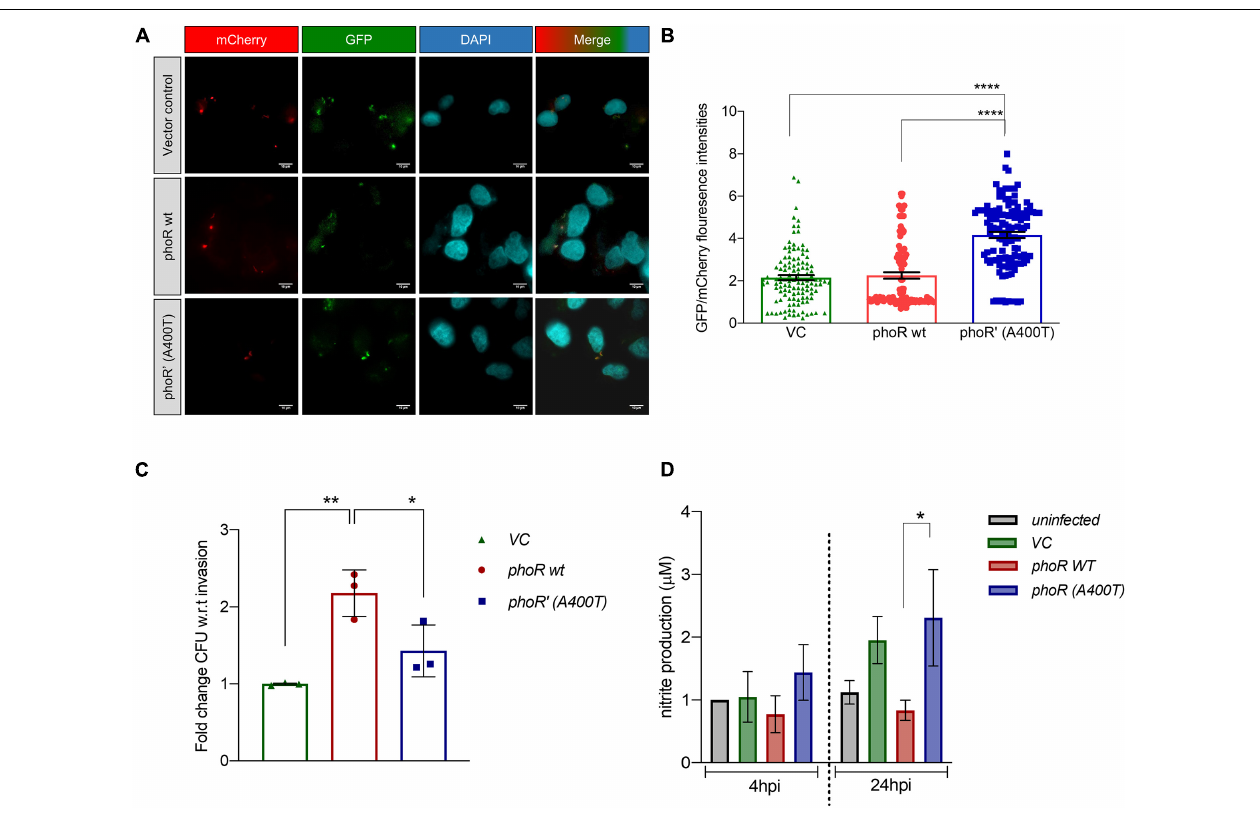
FIGURE 6 | Analysis of the effect of the phoR polymorphism by infection studies in host cells using H37Ra strain as a host strain. (A) Fluorescence microscopy images showing aprA induction upon infection in H460 lung epithelial cell line at 4 hpi. Top panel, a strain carrying vector alone; middle panel, PhoR wt; and lower panel, PhoR’ (A400T) mutant. mCherry marks constitutive promoter activity; green fluorescent protein (GFP), aprA marks promoter activity; DAPI marks the nucleus of the host cell; and merged image shows localization for all fluorophores. The brightness of merged image was increased to show presence of bacillary signal. (B) Quantification of relative fluorescence 4 hpi of intracellular bacilli by GFP/mCherry ratio for ∼ 100 bacilli. Cells were infected with H37Ra strains carrying aprA promoter-reporter plasmid along with an integrated copy of the empty vector, or vector containing either the wild-type or mutant phoPR operon. (C) Quantitation of the intracellular bacterial burden for various strains (as indicated) after infection in THP-1 differential macrophage cell line. Cells were infected with H37Ra strains an integrated copy of the empty vector, the wild-type or mutant phoPR operon. Colony-forming units (CFUs) obtained at 24 hpi are shown. (D) Measurement of NO production in supernatants of uninfected and infected THP-1 cells by the Griess test at various time points. Cells were infected with strains described above, and the NO/nitrite levels at 4 hpi were measured; left panel, 24 hpi; right panel, 72 hpi. The nitrite produced is normalized to the uninfected cells at 4 hpi. For all experiments, n = 3, where n represents the number of biological replicates used in the experiments. p -values, * ≤ 0.05, ** ≤ 0.01, *** ≤ 0.001, and **** ≤ 0.0001, were determined by one-way